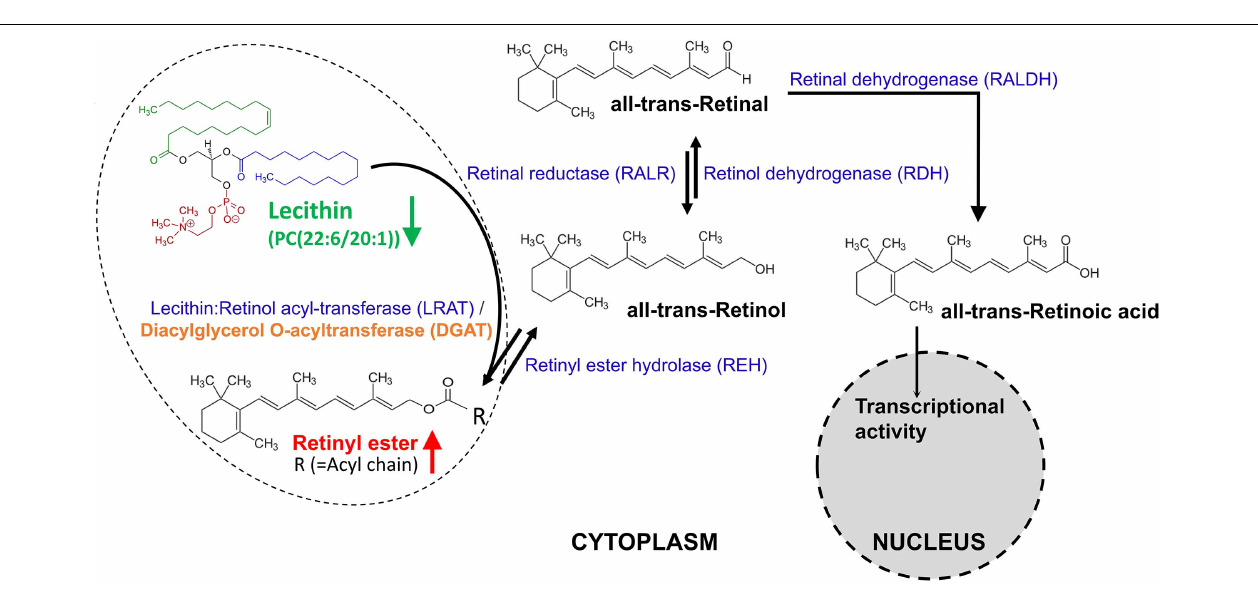
FIGURE 6 | The metabolism of retinoids. Retinal can be originally formed by the cleavage of proretinoid carotenoids such as beta-carotene by the enzyme BCMO1 (not shown here). Retinol is formed by the reversible reduction of retinal by one of the retinal reductase family members. The enzyme lecithin:retinol acyl-transferase (LRAT) [with an ortholog gene called diacylglycerol O -acyltransferase (DGAT) in Schistosoma ] synthesizes retinyl esters by transferring a fatty acyl moiety from the sn-1 position of membrane phosphatidyl choline such as lecithin [PC(22:6/20:1)] to retinol. Unesterified retinol is liberated from retinyl ester stores by the catalysis of a retinyl ester hydrolase (REH). Retinol is oxidized by catalysis of one retinol dehydrogenase (RDH) to retinal, which is then irreversibly oxidized by one retinal dehydrogenase (RALDH) to form transcriptionally active retinoic acid. Retinoic acid is finally oxidized/catabolized to more water-soluble hydroxy- and oxo- forms by one of several cytochrome P450 enzyme family